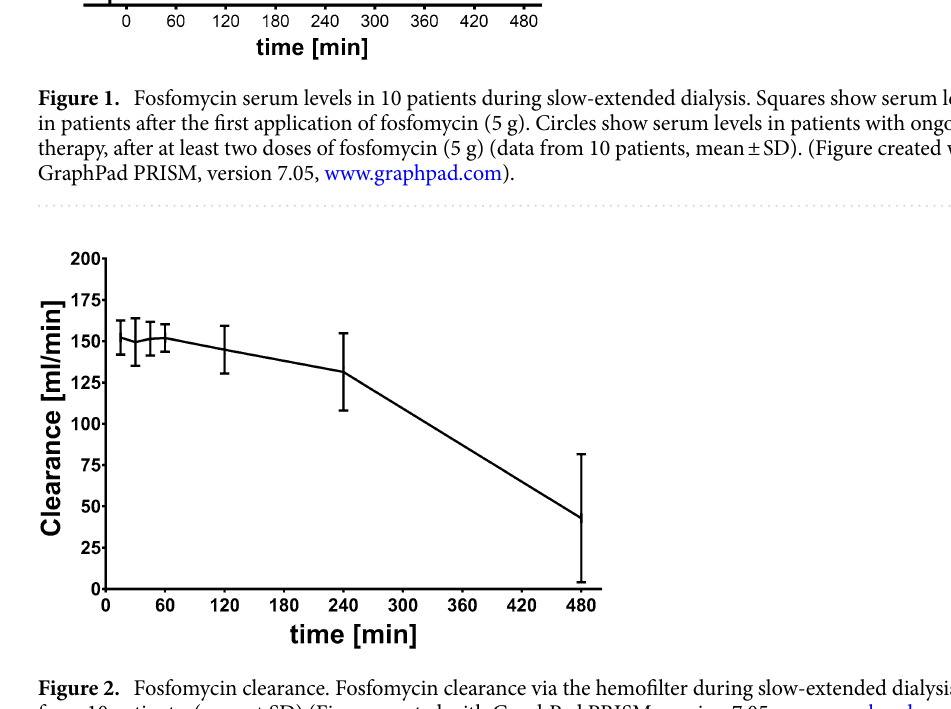
Figure 2. Fosfomycin clearance. Fosfomycin clearance via the hemofilter during slow-extended dialysis (data from 10 patients, (mean ± SD) (Figure created with GraphPad PRISM, version 7.05, www. graph pad.